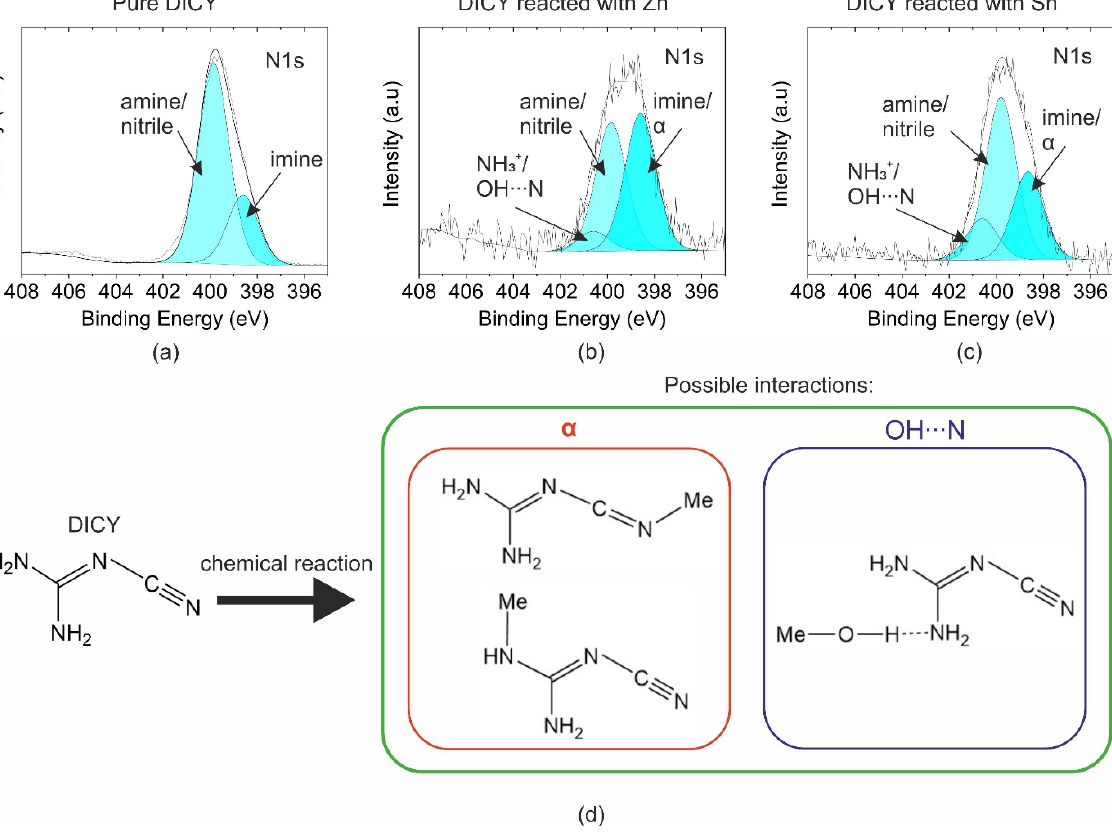
Figure 4. XPS N1s HR peaks of pure DICY ( a ), DICY residues on Zn ( b ), and DICY residues on Sn ( c ). The suggested chemical products and interactions are depicted in ( d ).